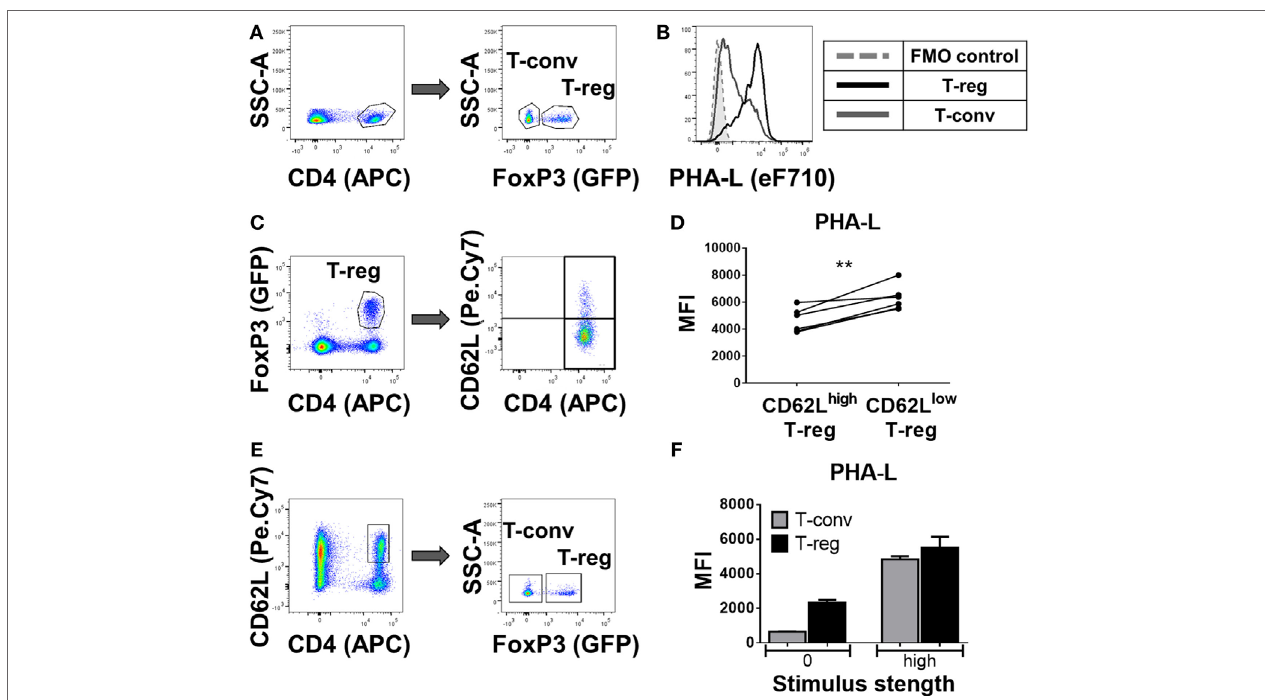
FigUre 2 | Complex tri/tetra-antennary N -glycan expression is higher in Treg than Tconv and is upregulated upon activation stimuli. (a) Flow cytometric identification of CD4 + FoxP3 + Treg (GFP + ) and CD4 + FoxP3 − Tconv (GFP − ) from C57BL/6 FoxP3.EGFP mouse spleen. (B) Comparison of Phaseolus vulgaris leucoagglutinin (PHA-L) binding to freshly isolated Treg and Tconv. (c) Gating strategy for the flow cytometric analysis of the CD62L high and CD62L low GFP + Treg subsets. (D) Graph representing the Median Fluorescence Intensity (MFI) of PHA-L binding to CD62L high and CD62L low GFP + Treg subsets ( n = 6 individual animals). (e) Gating strategy of FACS purification of naïve CD4 + CD62L high T-cells (left) and subsequent analysis of GFP − Tconv and GFP + Treg. (F) MFIs of PHA-L binding to Tconv and Treg following 5-day culture of purified CD4 + CD62L high T-cells with no stimulus (0) or with anti-CD3/CD28 mAb stimulus (high). Results shown are representative of three similar experiments ( n = 3 technical replicates per condition). Statistical analysis was performed by permutation test with a paired design (** p value <